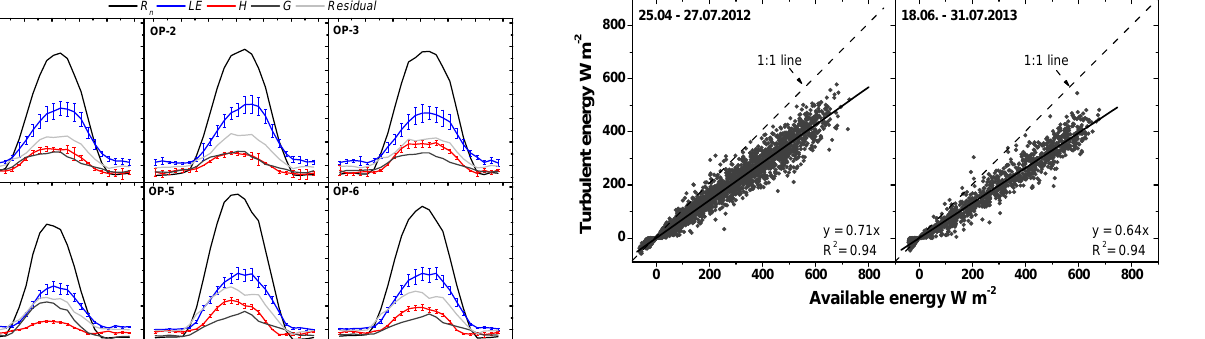
Figure 6. Scatter plots and linear regressions between turbulent and available energy in the periods from April to July 2012 and 2013. The 1:1 line indicates perfect energy balance closure.